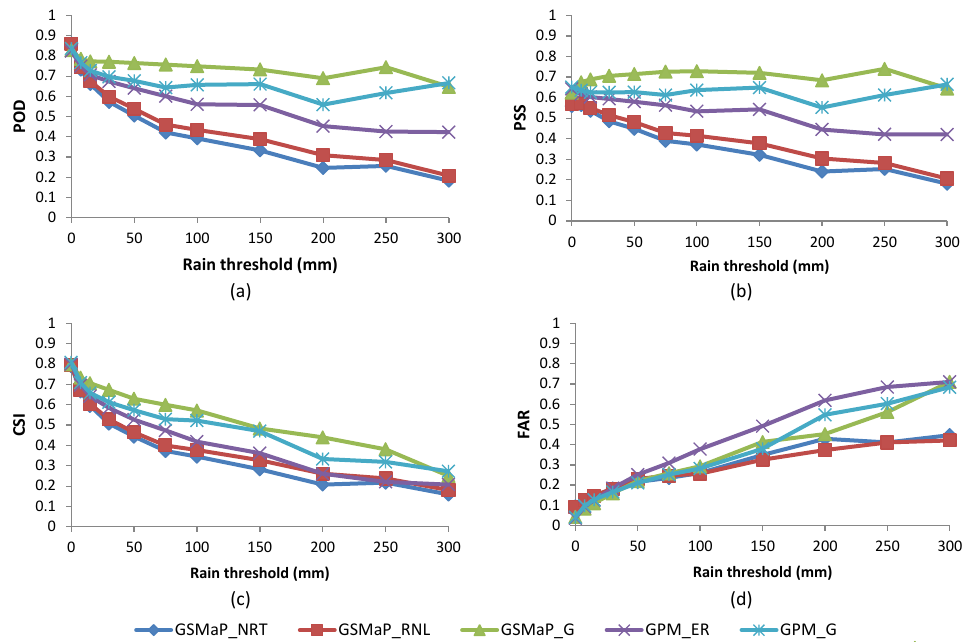
Figure 5. Contingency scores ( a ) POD, ( b ) PSS, ( c ) CSI, and ( d ) FAR of GSMaP_NRT, GSMaP_RNL,